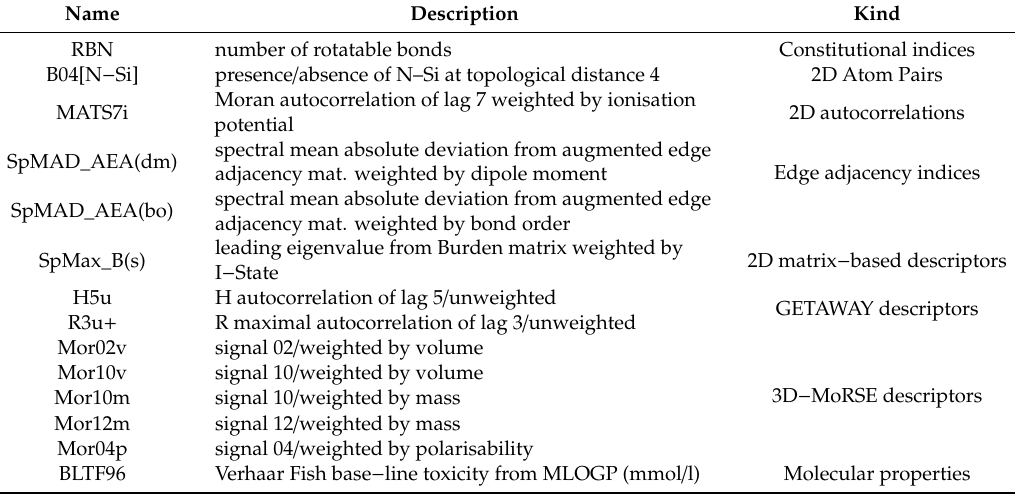
Table 4. Meaning and class of the molecular descriptors of the QSRR